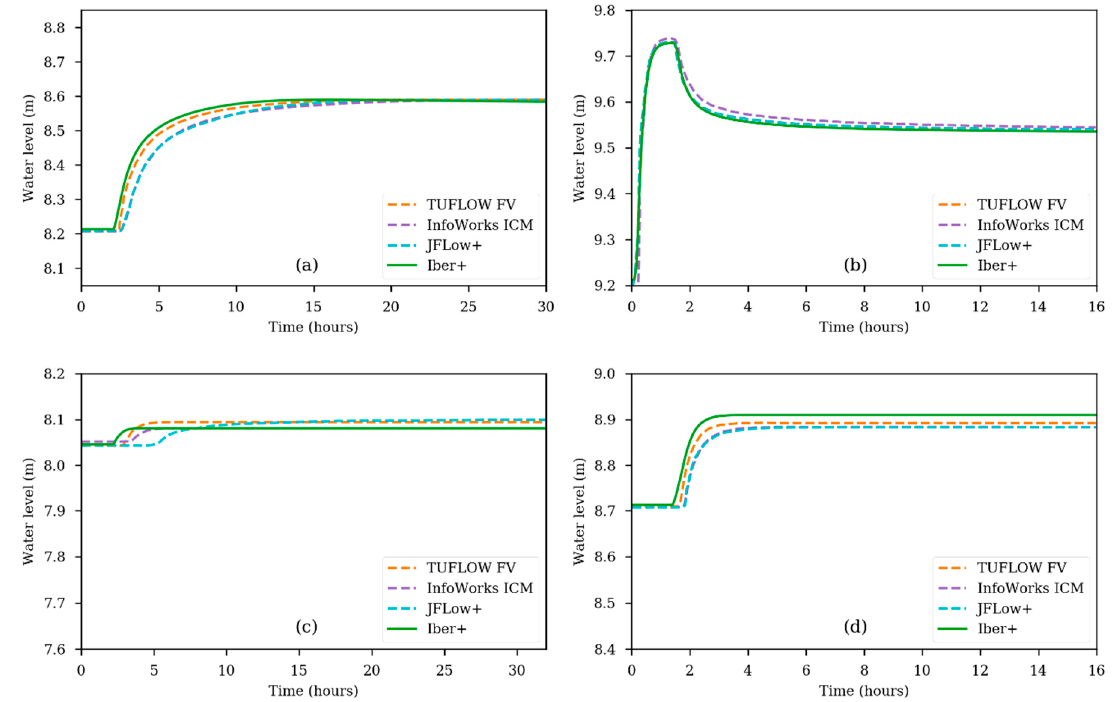
Figure 7. Water level time series for Test 2 obtained with different numerical models at Point 1 ( a ); Point 4 ( b ); Point 10 ( c ); Point 12 ( d ).